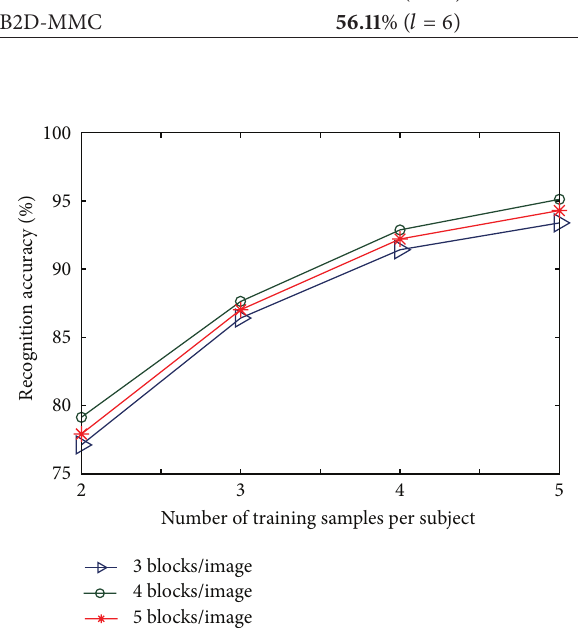
Figure 6: Recognition performance on the Yale dataset for different number of blocks per